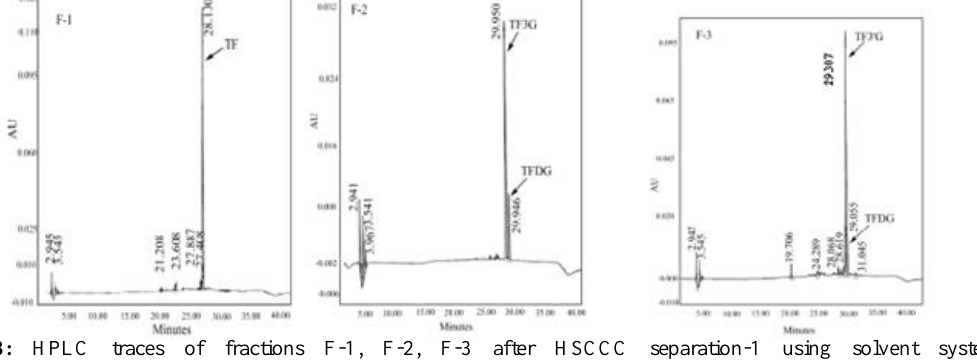
Figure 3: HPLC traces of fractions F-1, F-2, F-3 after HSCCC separation-1 using solvent system B Hex:EtOAc:MeOH:water (1:4:1:4) Conditions: Luna-5 µm Phenyl-Hexyl colum 4.6 ×250 mm with guard column of the same material: binary gradient with 9% (v/v) acetonitrile, 2% (v/v) acetic acid with 20 µg/ml EDTA (mobile phase A) 80% (v/v) acetonitrile, 2% (v/v) acetic acid with 20 µg/ml EDTA (mobile phase